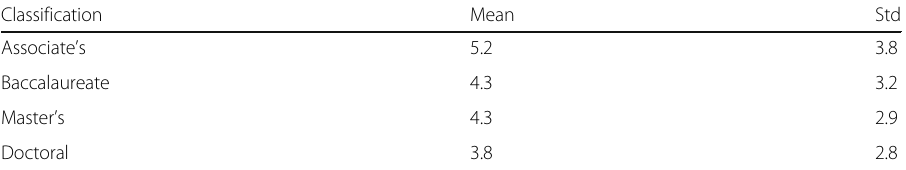
Table 3 Mean number of attempts for associate ’ s, baccalaureate, master ’ s and doctoral colleges with two troublesome KCs removed